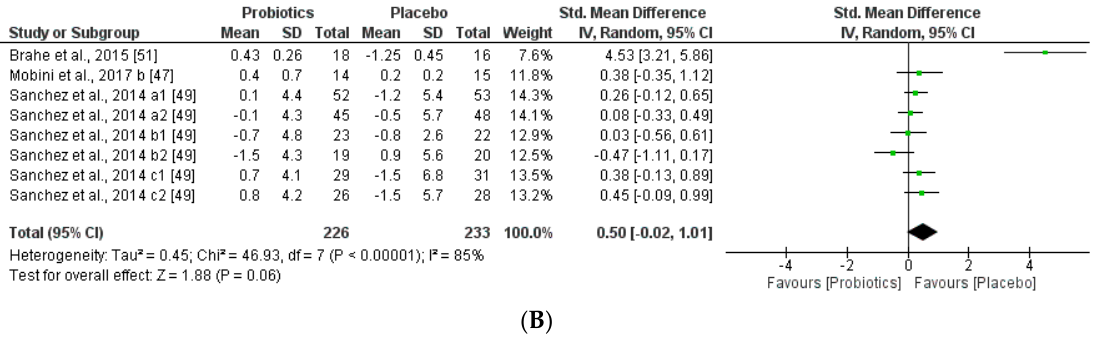
Figure 10. ( A ) Effect of probiotics on fasting plasma glucose in CT. ( B ) Effect of probiotics on CRP in CT.